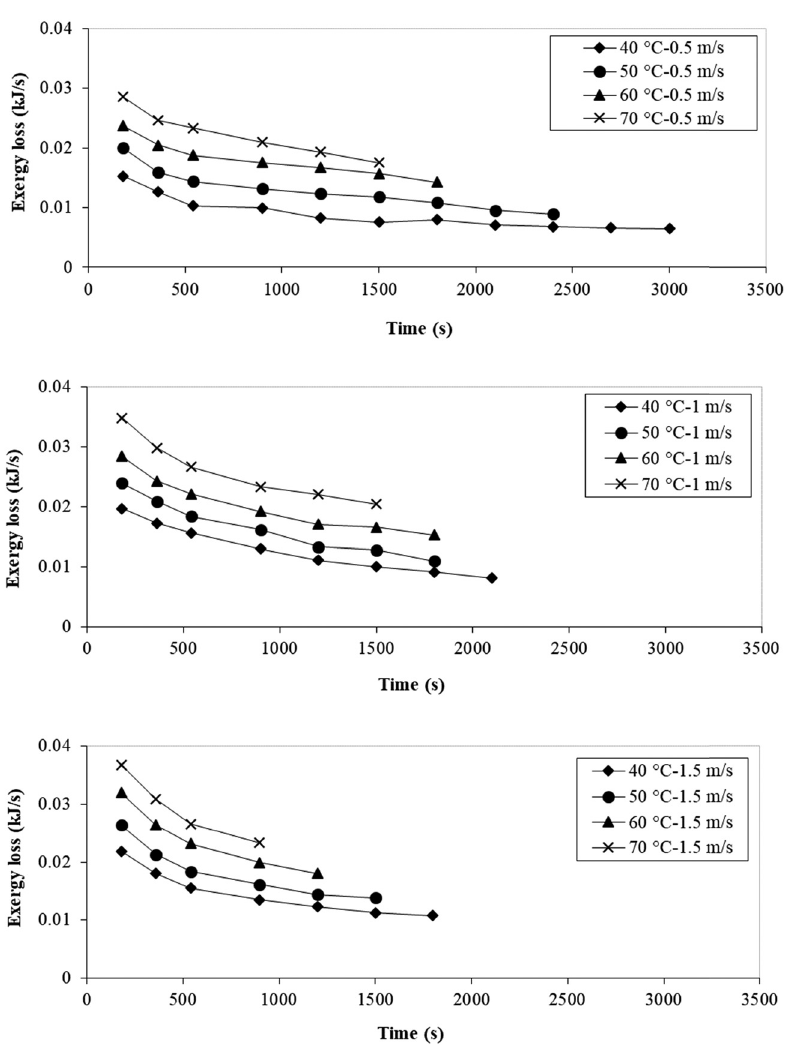
Figure 3: In fl uence of air temperature and velocity on the exergy losses for the drying of potato